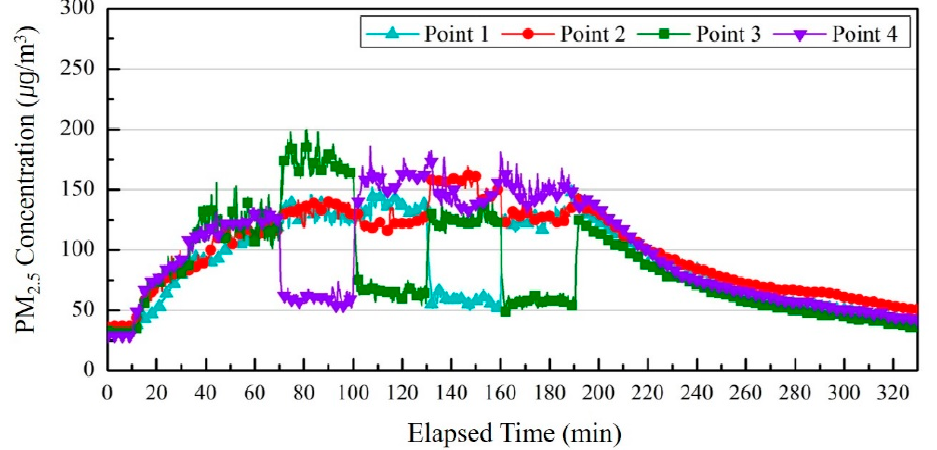
Figure 15. Comparing PM 2.5 concentrations by measurement points according to the operation of the air purifier that controls zones. air purifier that controls